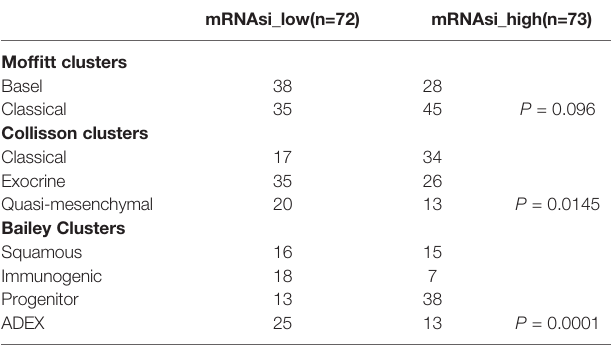
TABLE 2 | The distribution of patients with previously reported molecular subtypes between the different mRNAsi groups.